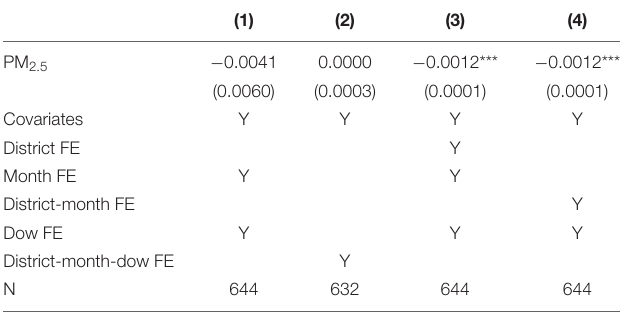
TABLE 4 | Main results of component blood donation. TABLE 5 | Heterogeneous relationship in different types of component